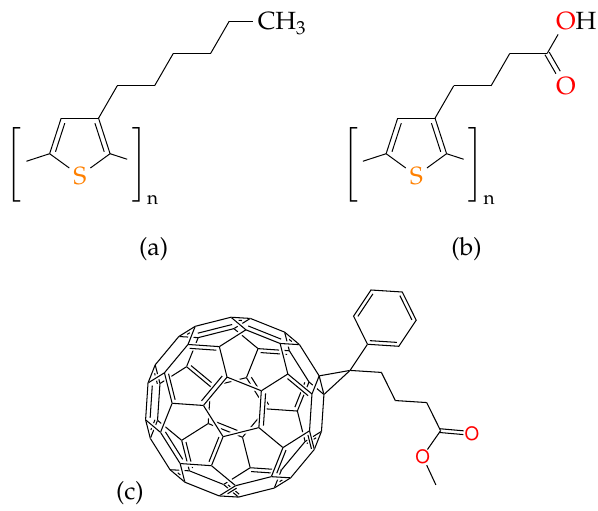
Figure 1. Schematic chemical structures of polymeric materials P3HT ( a ), P3BT ( b ) and PCBM ( c ). For better contrast, sulphur sites are marked orange, and oxygen sites are marked red.